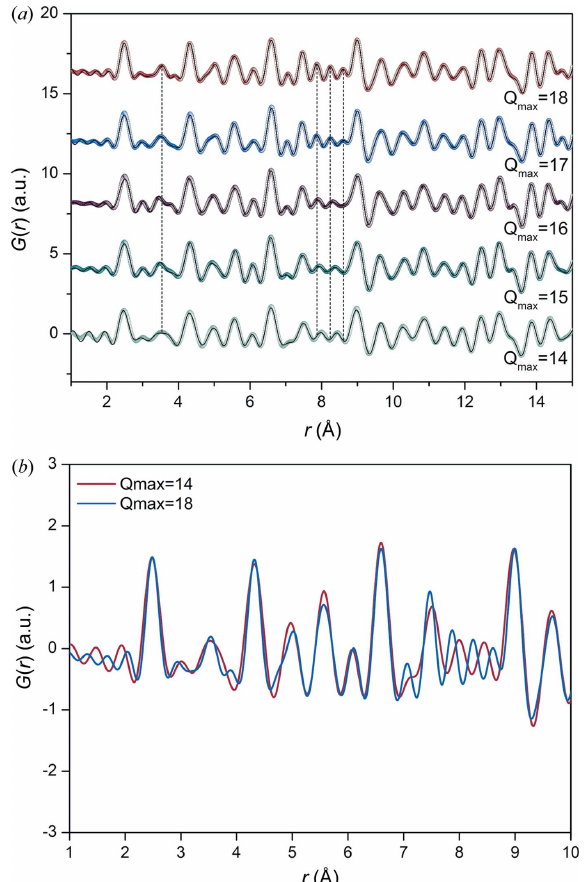
Figure 2 Data for an Ni sample show the ( a ) difference in resolution for Q max = 14 A˚ (cid:2) 1 to 18 A˚ (cid:2) 1 , and ( b ) loss of resolution observed for Q max = 14 A˚ (cid:2) 1 compared with Q max = 18 A˚ (cid:2) 1 . In ( a ) the dotted plot is the measured data, and the line (black) shows the calculated